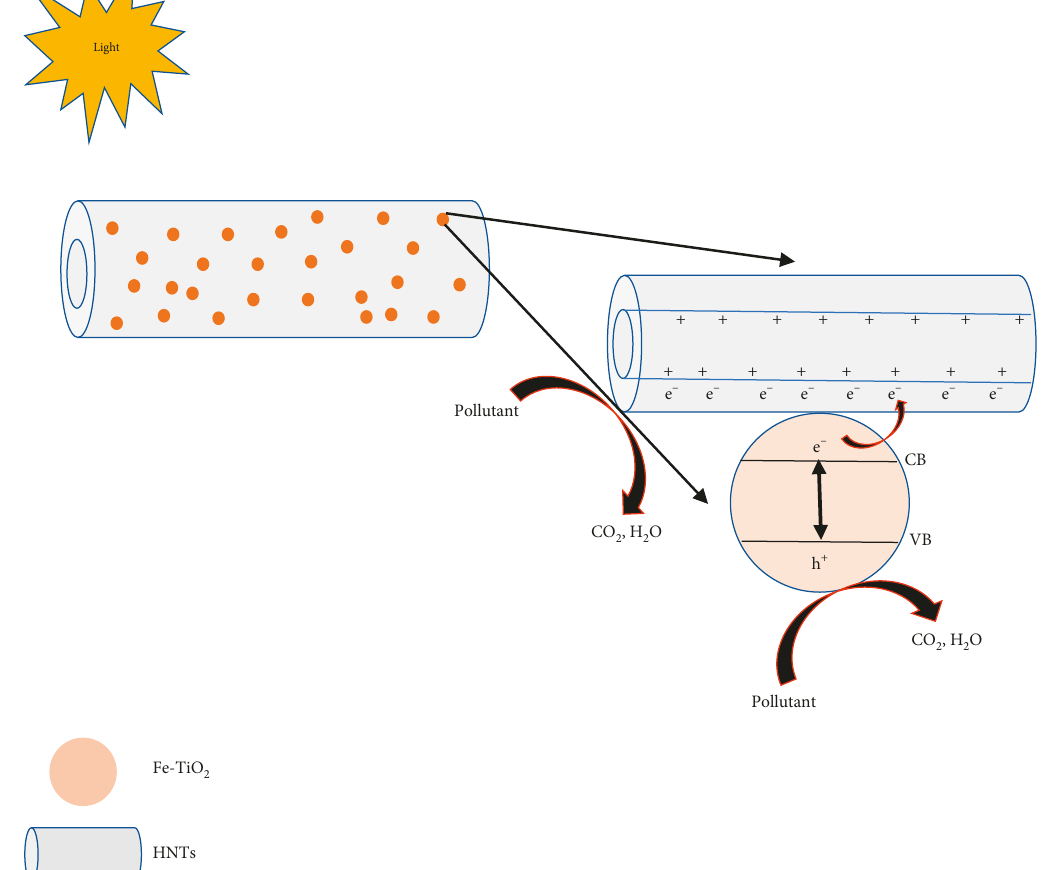
Figure 10: Schematic representation of the photocatalytic degradation of organic